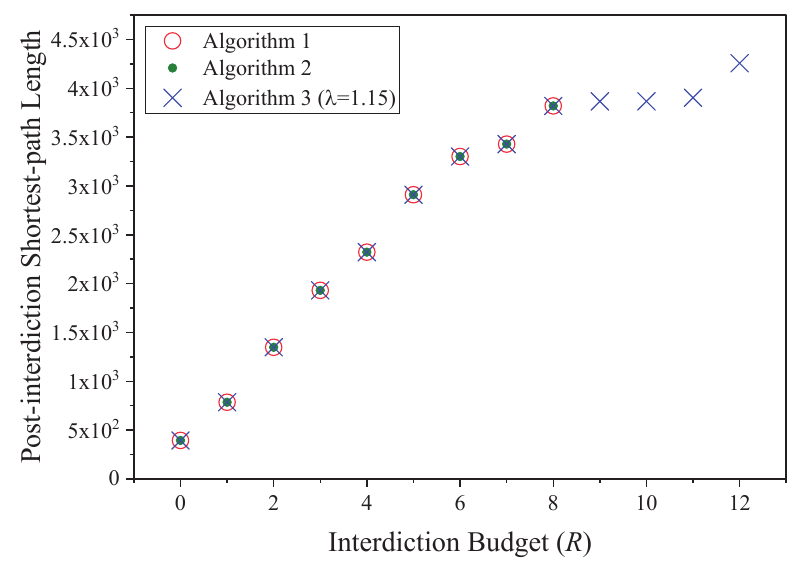
Figure 4. Interdiction effects in the bi-layer IoT